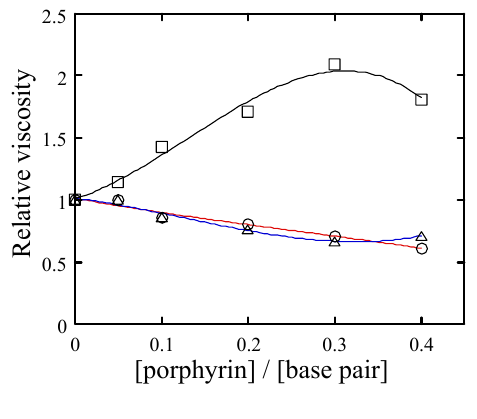
pXy (open circles) and H 2